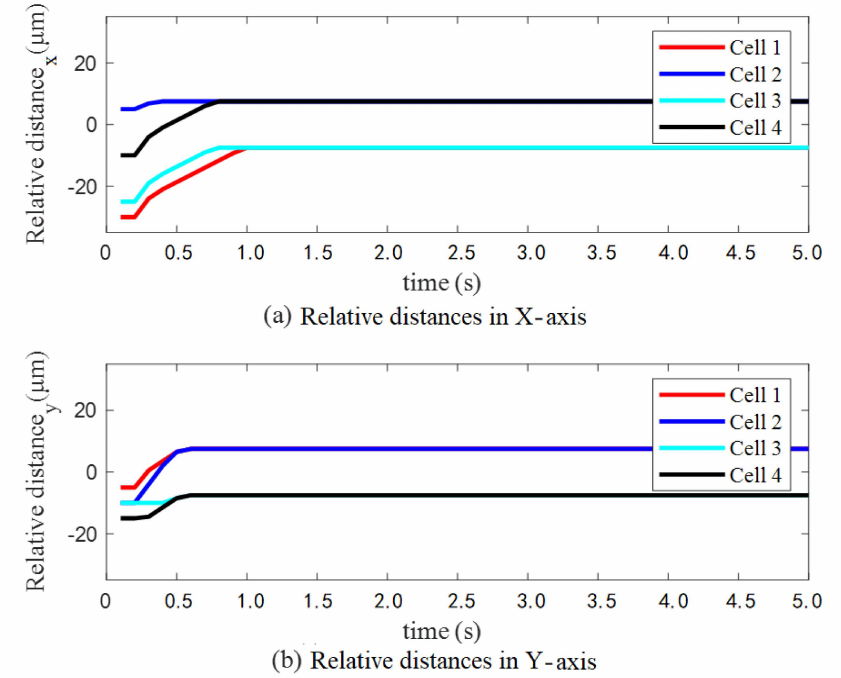
Figure 11. Relative distance between the controlled cell and the virtual